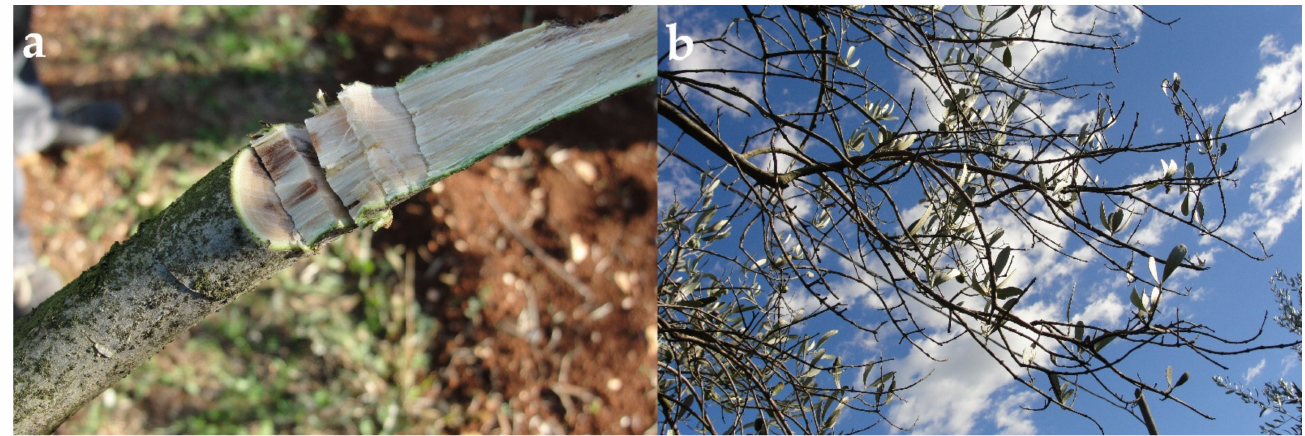
Figure 1. ( a , b ) Disease symptoms on olive branches in an orchard near Rovinj in Istria, Croatia, in the year